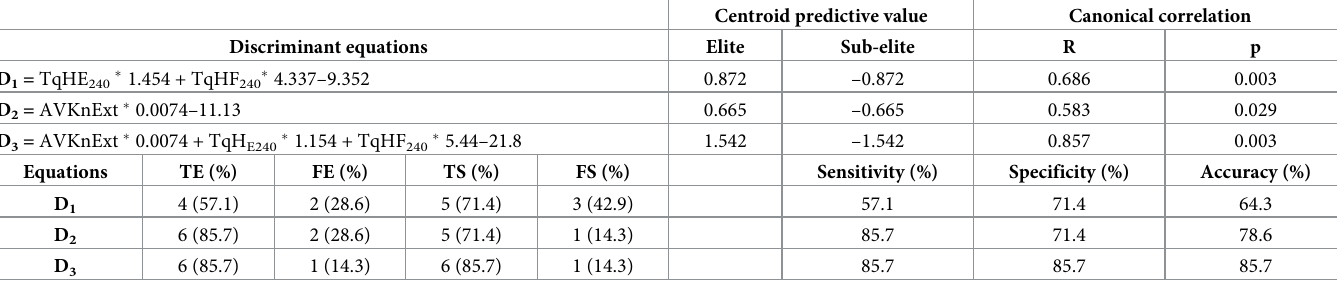
Table 3. Results of the discriminant analysis of the discriminant functions (D 1, D 2 , and D 3)